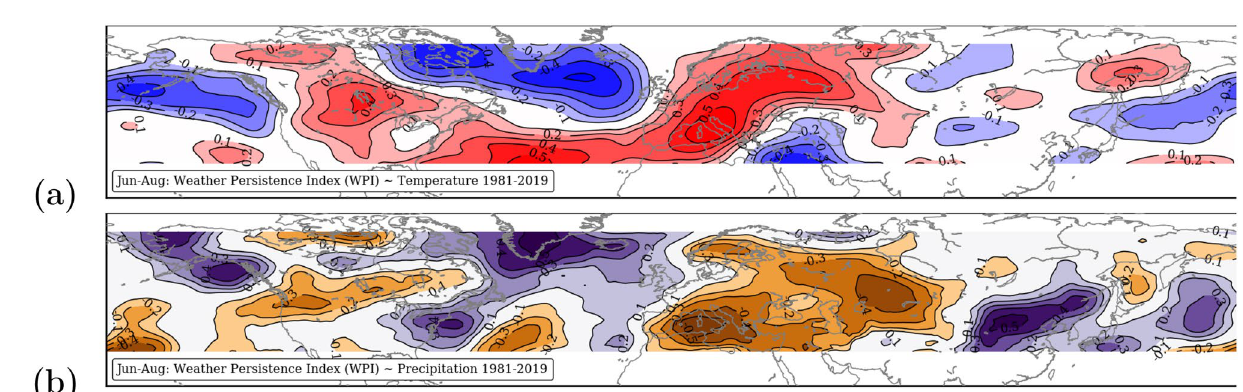
Figure 3. NH mid-latitude probability density patterns between summer means of WPI and temperature ( a ) and precipitation ( b ) from 1981 to 2019. The three circles correspond to conditions over Siberia (50 ◦ ◦ red), Pakistan (30 N/70 E, blue) in summer 2010 and Eastern Germany (52 individual years for Siberia (small red circles) are given for comparison to 2010. The plots were created by using python3-matplotlib (version 3.1.2, https:// matpl otlib. org/).